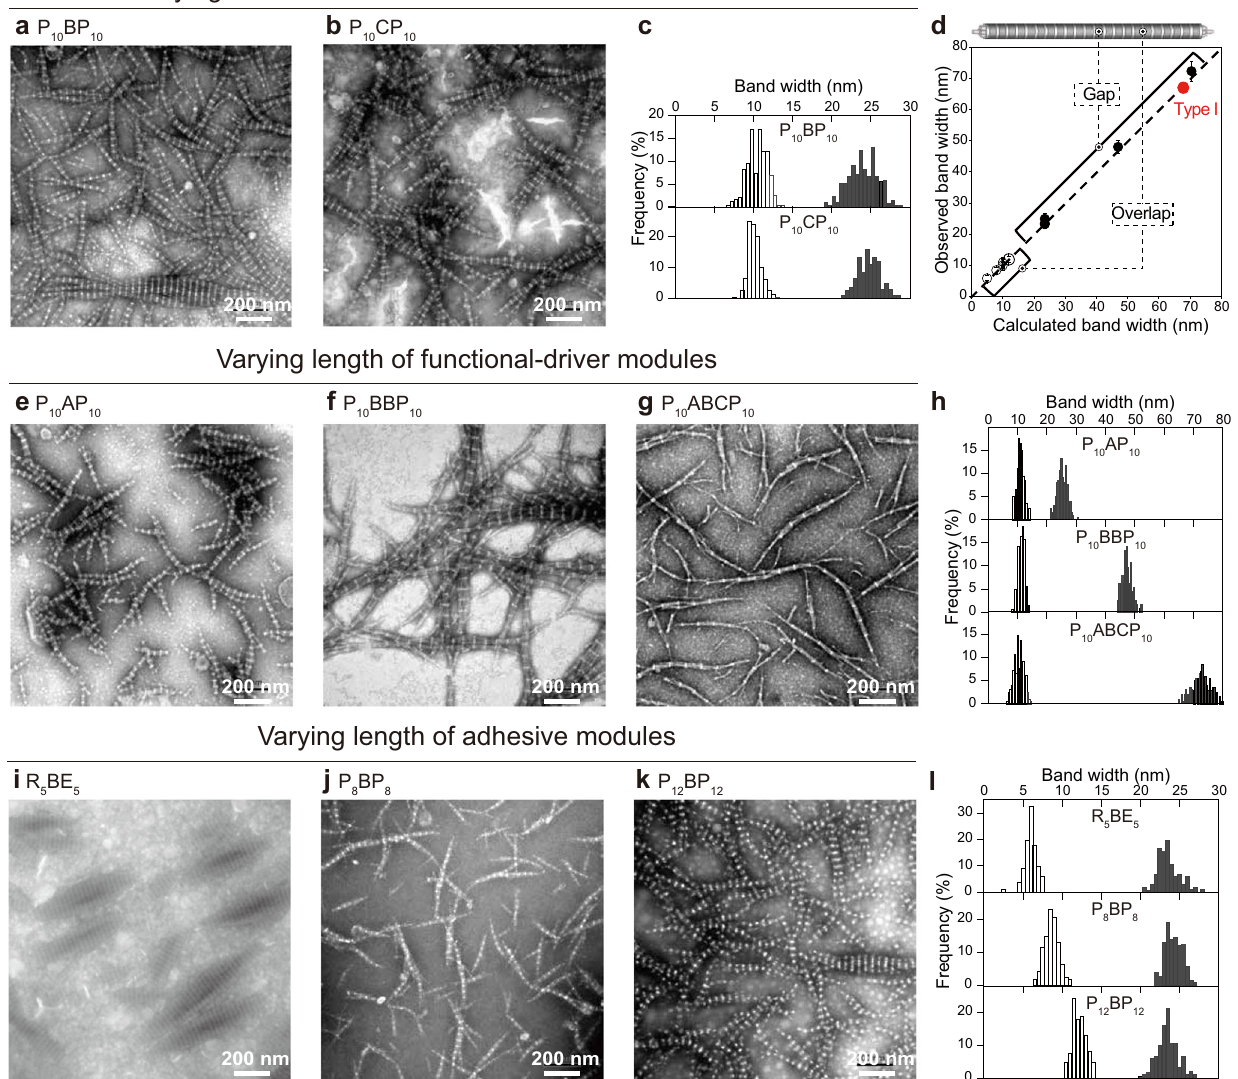
d Observedbandwidthswereplottedagainstthosecalculatedfrommodulelength, multiplied by the average helical rise (~2.9Å) per residue 61 . The 67nm Type I col- lagen D-period assumes a repeat length of 234 residues 32 . The dashed lines indi- cated that the light and dark bands of the synthetic collagen, respectively, correspond to the overlap and gap region of Type I collagen. Solutions of the designed collagens at 0.5mM in 10mM phosphate buffer (pH 7.0) were incubated at 4°C for 3 days, then negatively stained, and visualized with Transmission